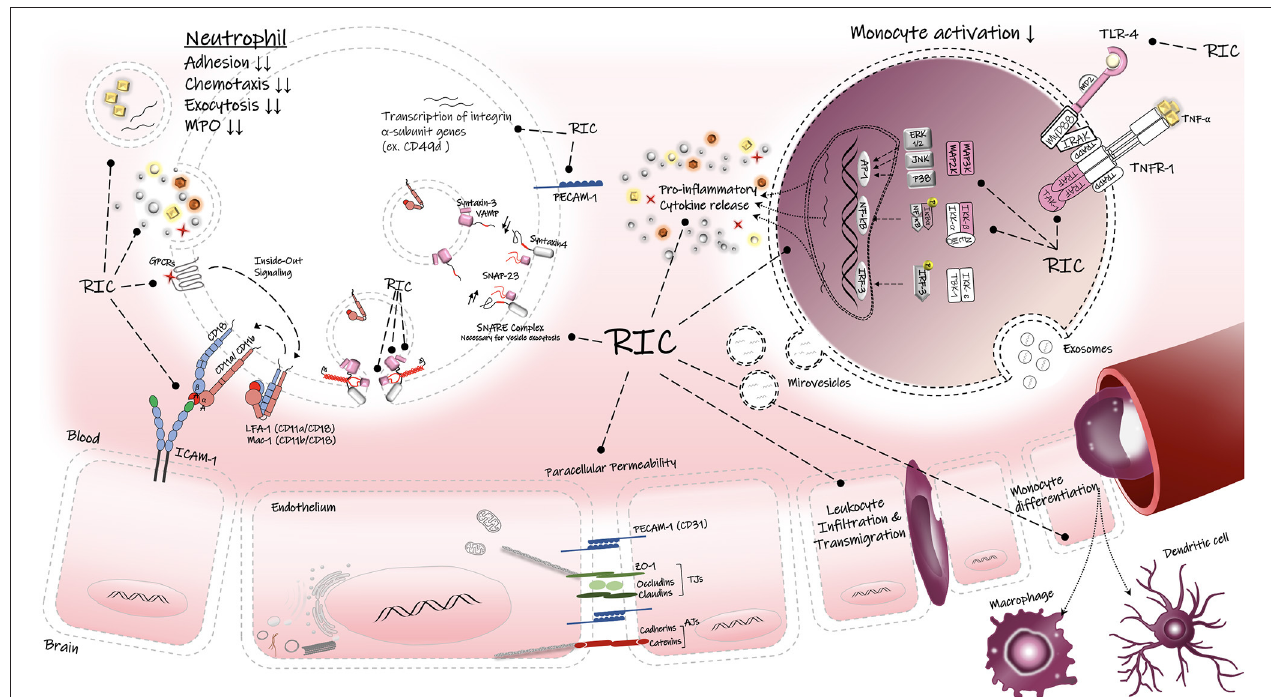
FIGURE 3 | Regulatory effects of RIC on inflammatory responses. RIC can decrease the peripheral immune activation, infiltration and transmigration into the brain parenchyma. RIC can suppress the TLR-4/NF- κ B associated proinflammatory cytokine release in the immune cells. LFA-1, lymphocyte function-associated antigen-1; Mac-1, macrophage-1 antigen; ICAM-1, intercellular adhesion molecule-1; PECAM, platelet endothelial cell adhesion molecule-1; Z0-1, zonula occludens-1; AJs, adherens junctions; TJs, tight junctions, TNF- α , tumor necrosis factors-alpha; TNFR1, tumor necrosis factors receptor type-1; TLR-4, toll-like receptor-4; SNAP-23, synaptosomal-associatedprotein-23; VAMP, vesicle-associated membrane protein; GPCRs, G protein-coupled receptor; TAK1, transforming factor- β -activated kinase 1; I κβα inhibitor kappa beta